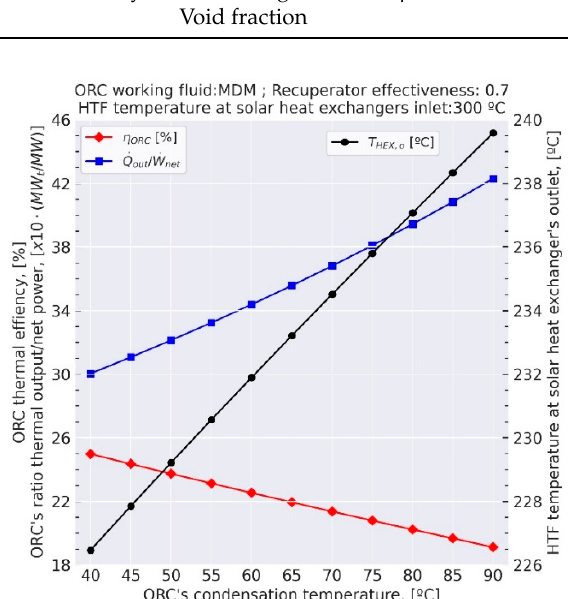
Figure 7. Effect of the ORC’s condensation temperature on thermal efficiency, heat output to net power output ratio, and HTF’s temperature at the solar heat exchangers’ outlet.